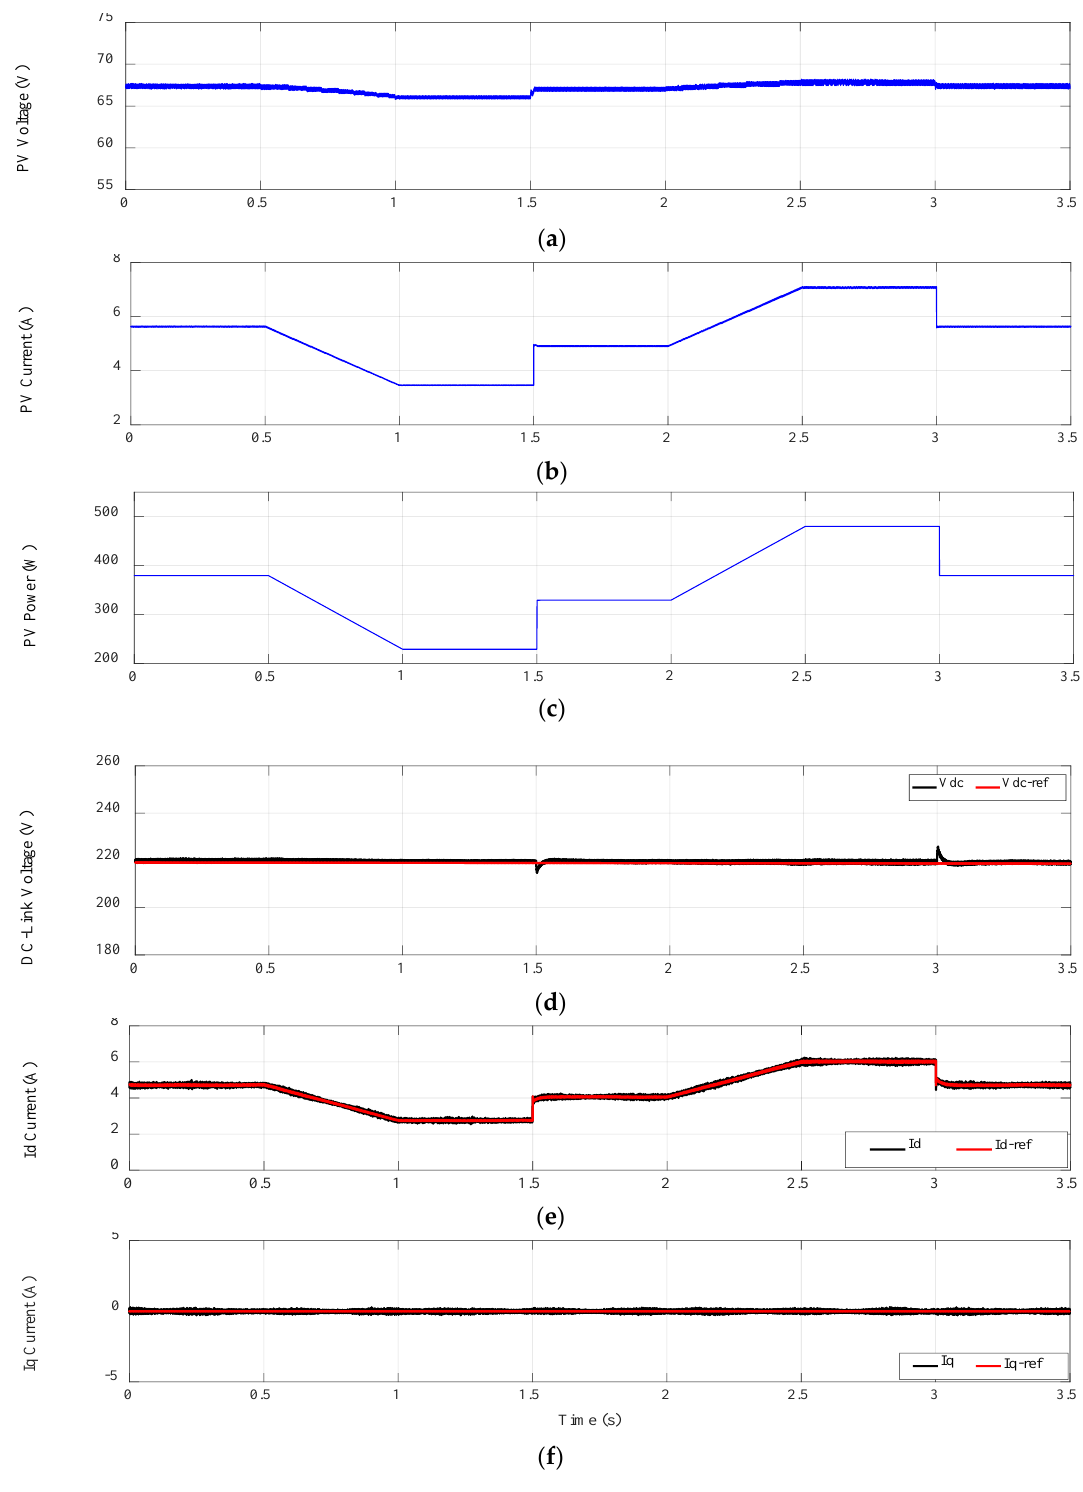
Figure 12. Simulation results of grid-tied PV system with the proposed control scheme; under irradiation changes. ( a ) PV Voltage; ( b ) PV Current; ( c ) PV Power; ( d ) DC−Link Voltage; ( e ) Id Current and ( f ) Iq Current.